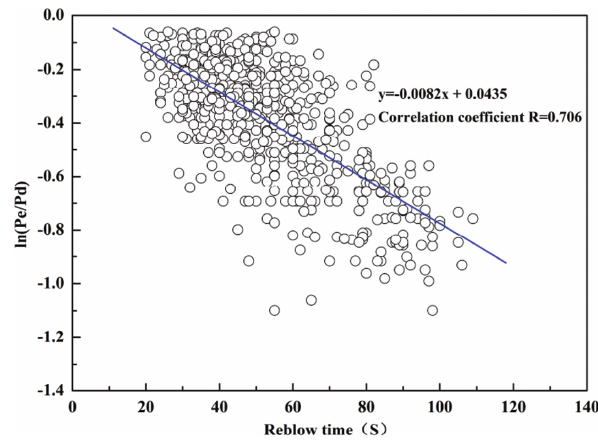
Figure 2: Relation between endpoint phosphorus content,